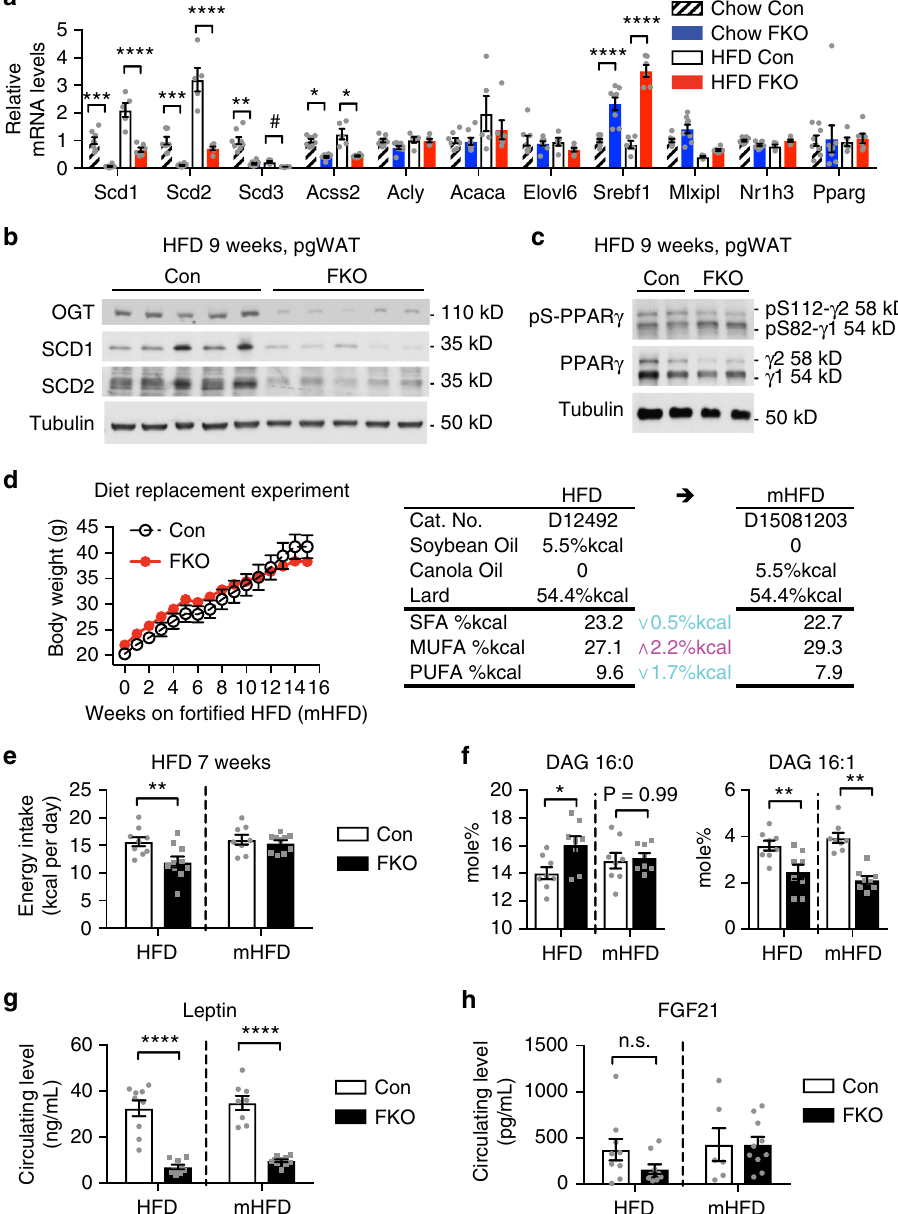
Fig. 4 Adipocyte OGT drives diet-induced hyperphagia through transactivation of lipid desaturation in adipose tissue. a Gene expression analysis of de novo lipid desaturation and synthesis in adipose tissue (Chow for 15 weeks, Con n = 8, FKO n = 8; age-matched HFD for 9 weeks, Con n = 5, FKO n = 6). b Protein levels of SCD and OGT in adipose tissue. c Western blotting analysis in adipose tissue from 9-week-HFD-fed FKO and Con mice (Con n = 5, FKO n = 6, two representative biological replicates were shown). d Growth curves and e energy intake of (m)HFD-fed Con and FKO mice ( n = 8 – 10 per group). mHFD denotes a mono-unsaturated fat-forti fi ed high-fat diet that changes the saturated fat-rich soybean oil fraction into the mono-unsaturated fat-rich canola oil as illustrated in the diagram ( d ). f Contents of palmitate (C16:0) and palmitoleate (C16:1) DAG in adipose lipidome, and circulating levels of leptin ( g ), or of FGF21 ( h ) in mice fed HFD or mHFD for 15 weeks. Data were presented as mean ± s.e.m. n.s. not signi fi cant, * P < 0.05, ** P < 0.01, **** P < 0.0001, post hoc Sidak ’ s tests ( a , e – h ), or # P < 0.01 HFD Con vs. HFD FKO, two-tailed Student ’ s t-test ( a ). A dashed line in ( e – h ) indicates that data from HFD study and mHFD study are presented in a side-by-side manner, and inference may not be made between different Srebf1 (Fig. 4a). Western blot analysis shows that OGT deletion decreased the protein levels of SCD1 and SCD2 in white adipose tissue (Fig. 4b and Supplementary Figure 12). A survey of expression of de novo lipogenic genes in both white and brown adipose tissues shows that OGT deletion selectively abolished the expression of Scd genes in white adipose tissues (Supplementary